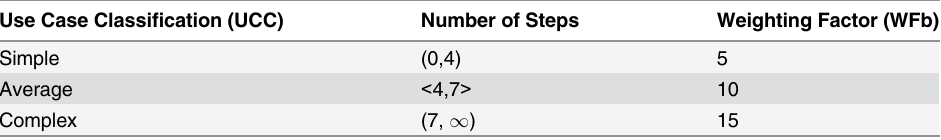
Table 2. Use Case Classification and Weighting